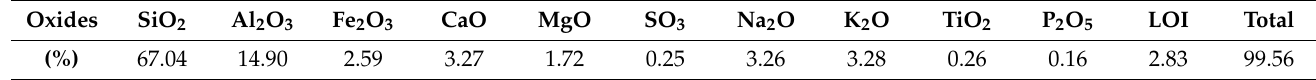
Table 2. The chemical composition of volcanic ash.